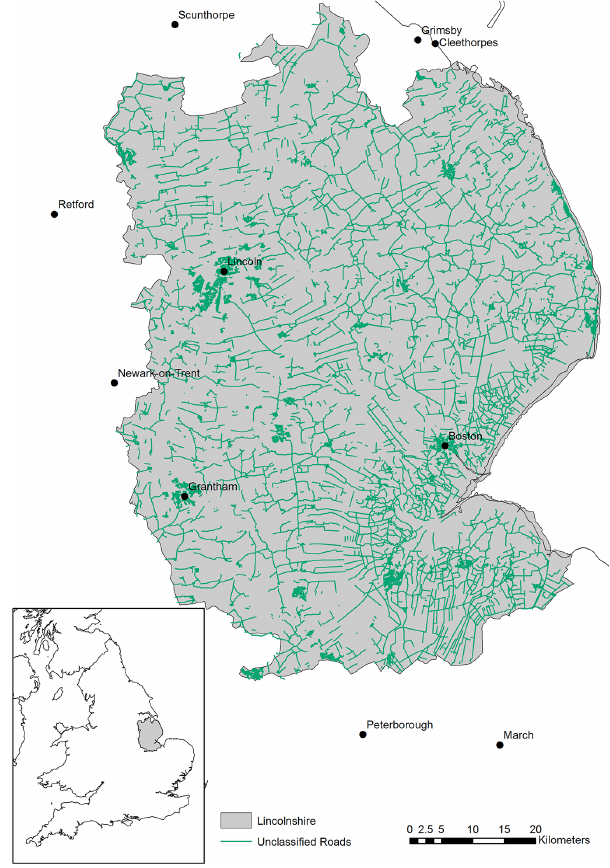
Figure 1. Lincolnshire location map and the distribution of unclas- sified roads.